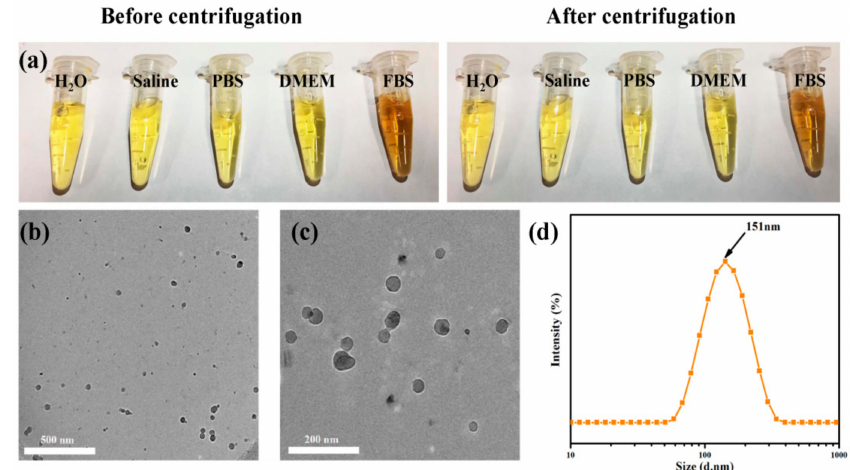
Figure 4. ( a ) photographs of C 60 -PDA-GSH in water, saline, PBS, and DMEM and FBS before and after centrifugation at 10,000 rpm for 10 min. ( b , c ) representative cryo-TEM images of C 60 -PDA-GSH with di ff erent magnification; ( d ) hydrodynamic size distribution of C 60 -PDA-GSH in